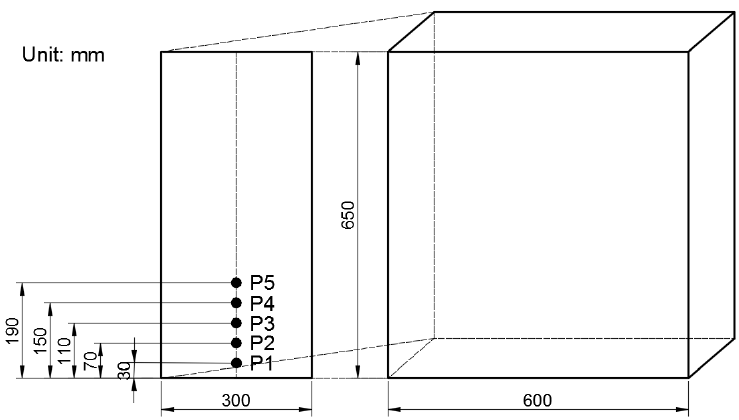
Figure 4. The inner dimension of the rectangular tank and the layout of five pressure sensors.